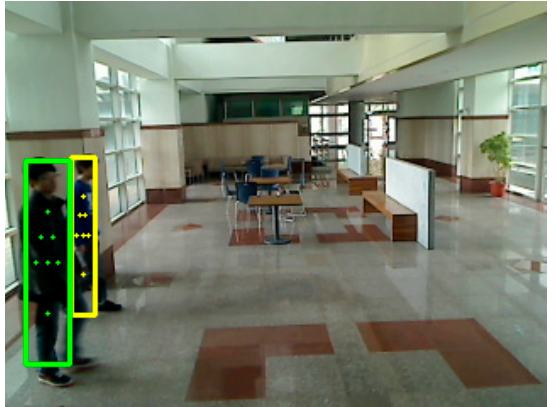
Figure 6. The Bounding Box of Person Detection.